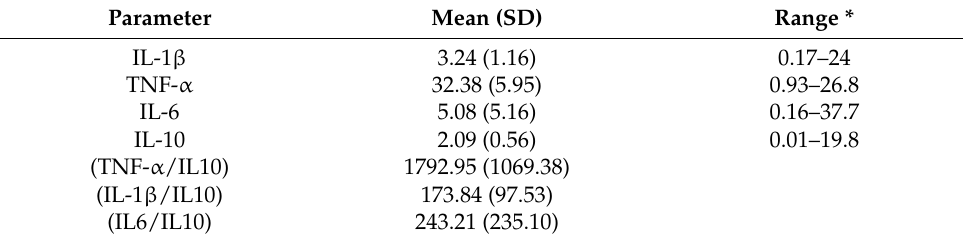
Table 4. Levels of selected cytokines involved in the cytokine storm of COVID-19 at baseline in the entire study population with vitamin D deficiency (n =